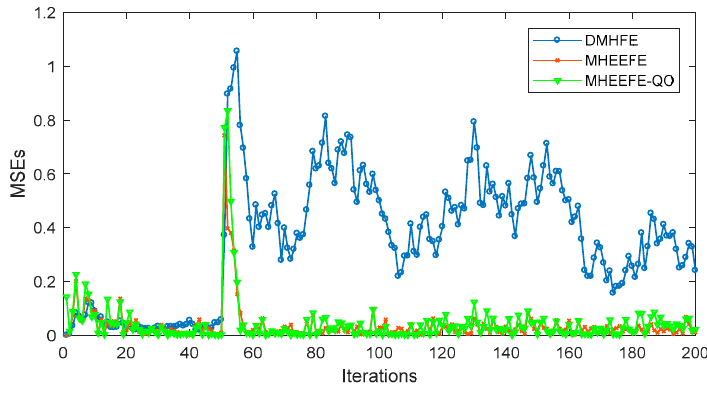
Figure 11. MSEs with a broken node.